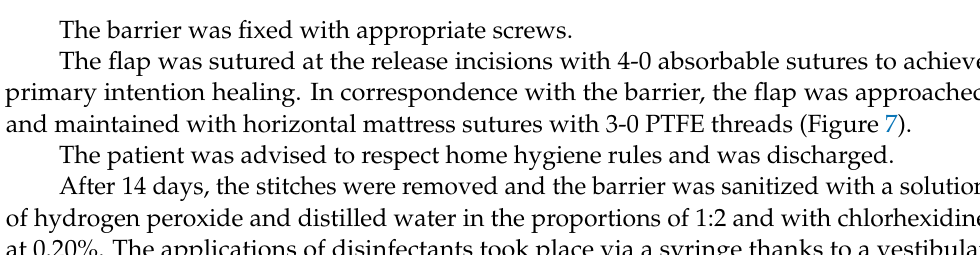
Figure 7. Detail of the sutures: resorbable for the release incisions and in PTFE to keep the flap close to the barrier. The patient was advised to respect home hygiene rules and was discharged. After 14 days, the stitches were removed and the barrier was sanitized with a solution of hydrogen peroxide and distilled water in the proportions of 1: 2 and with chlorhexidine at 0.20%. The applications of disinfectants took place via a syringe thanks to a vestibular housing created to sanitize the inside of the barrier during the healing period. The sani- tizing washes were repeated every 10 days until the barrier was removed. After 6 months, the barrier was removed. Under local anesthesia, de-epithelialization of the peri-barrier mucosal invagination was carried out. Small incisions were made to access the fixing screws where necessary. Then, after removing the screws, the barrier was removed. An abundant, highly vascularized, hard-elastic tissue formed within the barrier (Figure 8). The newly formed tissue retained some beta-tricalcium phosphate granules. In corre- spondence with the distal papilla of 1.5, there was appreciable keratinization of the tissue, which indicated an initial tissue maturation. The flaps were left in place and maintained with tissue acrylic glue (Periacryl ® by GluStitch Inc., Delta, B.C., Canada) (Figure 9).